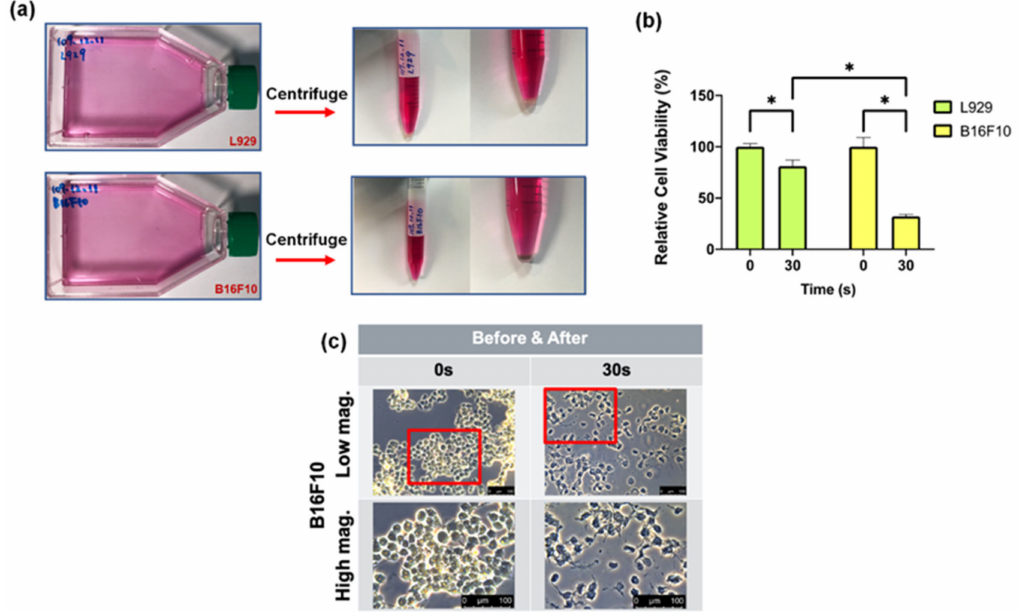
Figure 5. ( a ) Cell culture and collection of L929 and B16F10 cells. ( b ) Cell viability of L929 and B16F10 cells before and after plasma treatment. ( c ) B16F10 cell morphology was imaged by optical microscopy at different magnifications before and after transferred CAP treatment. (* p <